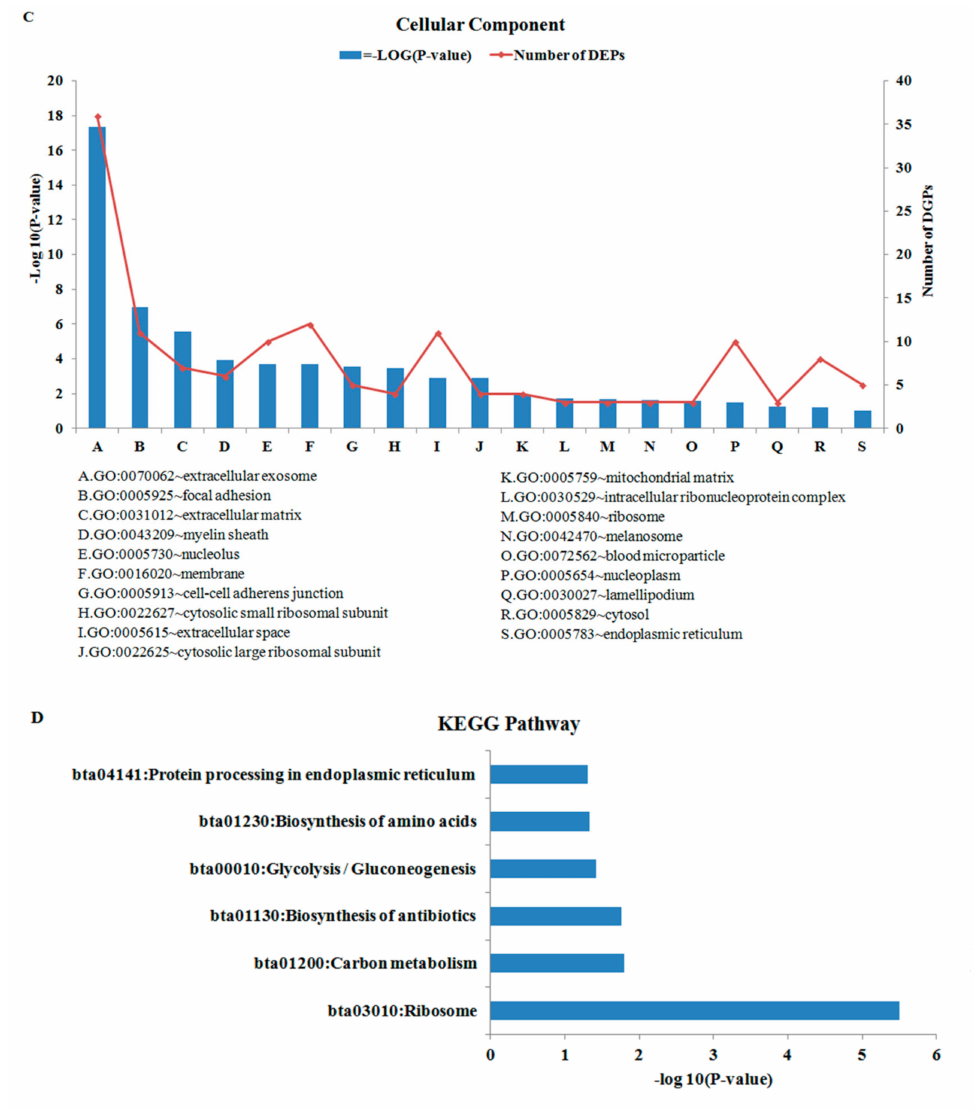
Figure 3. Gene ontology (GO) and Kyoto Encyclopedia of Gene and Genomes (KEGG) analysis of 66 common di ff erentially expressed proteins. Shown above is the classification of these proteins in di ff erent categories based on Biological Process ( A ), Cellular Component ( B ), Molecular Function ( C ), and KEGG pathway ( D ). The x-axis shows the functional categories of the increased or decreased proteins, the left y-axis shows the value of –Log ( p -value), and the right y-axis shows the number of increased / decreased